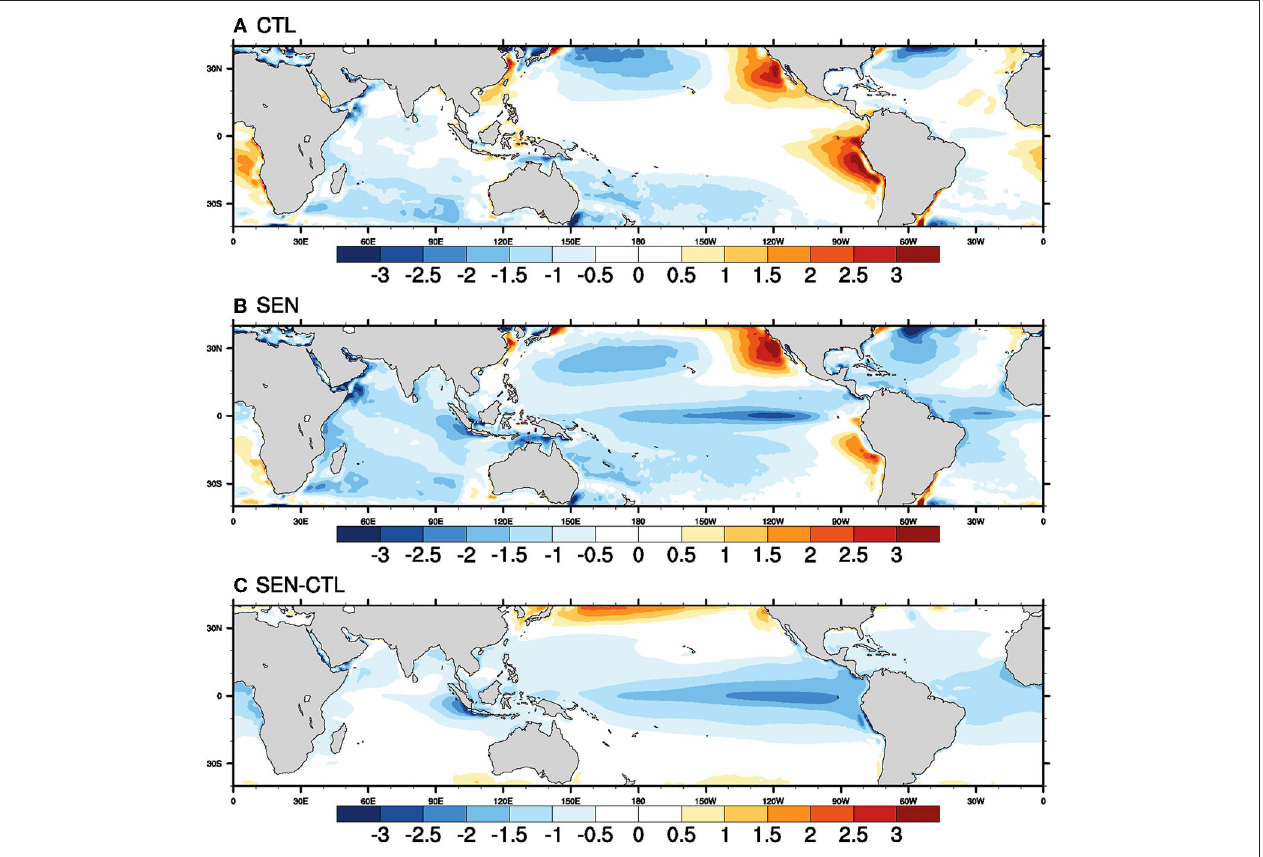
FIGURE 8 | Seasonal (JJAS) mean bias in temperature ( ◦ C) at 5m depth of the ocean in (A) CTL run, (B) SEN run, and (C) SEN-CTL for the period of